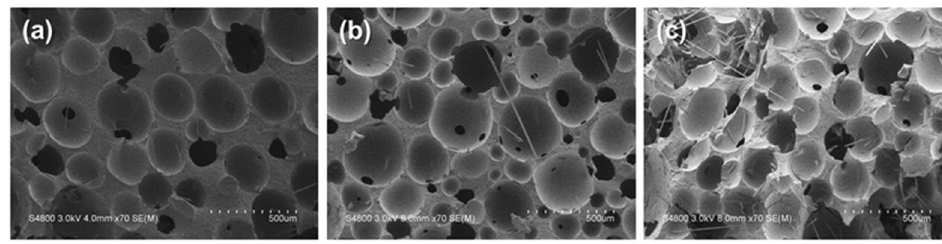
Figure 7. SEM images of ( a ) PU, ( b ) PU/C/80 g, and ( c ) PC/C/120 g.